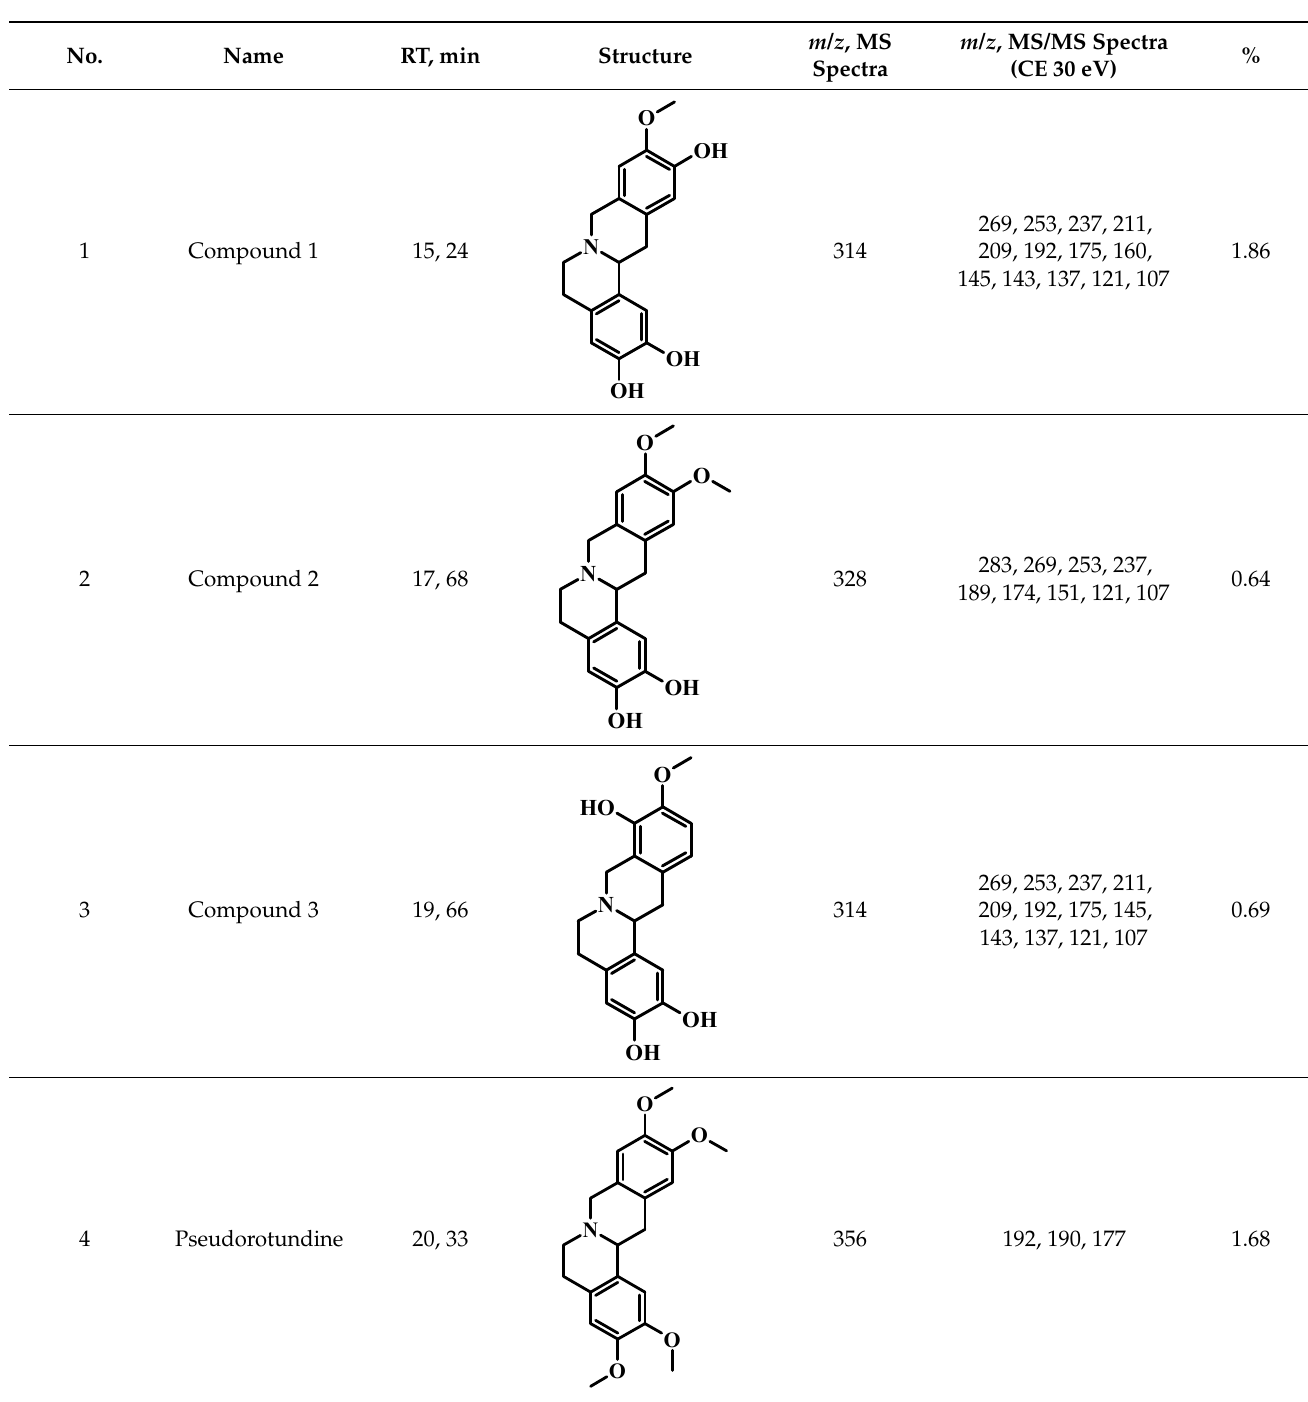
Table 5. Phytochemical composition of the optimized ethanolic bark extract of Enantia Chlorantha .